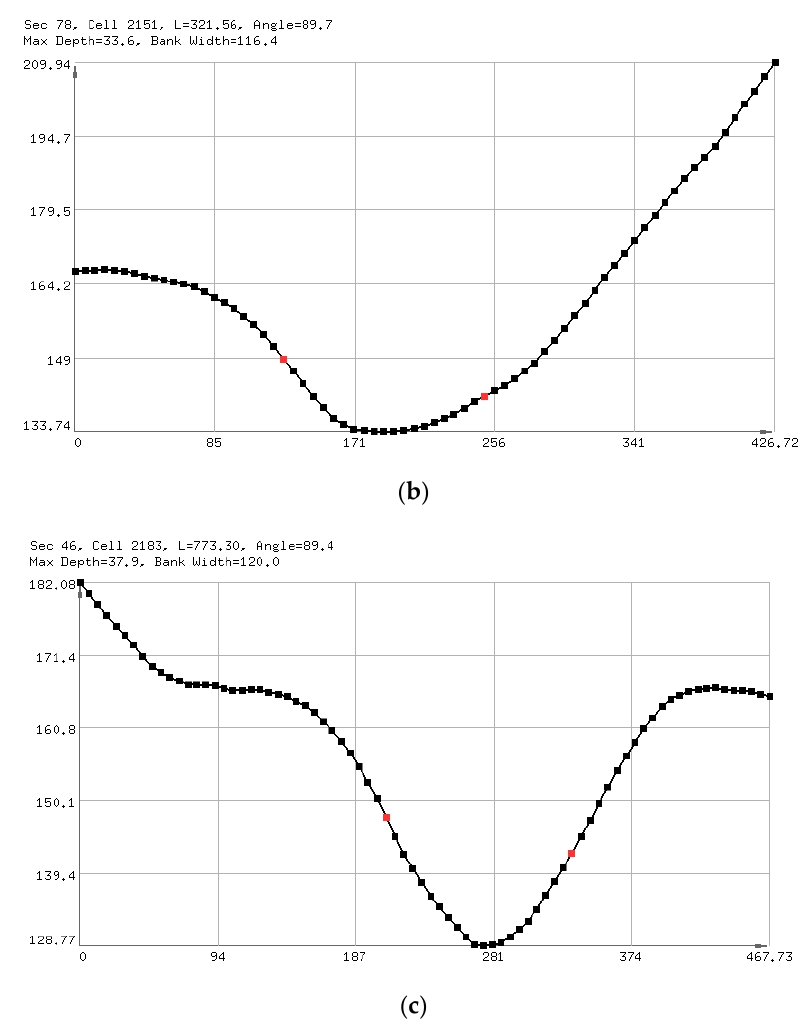
Figure 35. Representative sections of the first set. Sections 89 ( a ), 78 ( b ) & 46 ( c ).